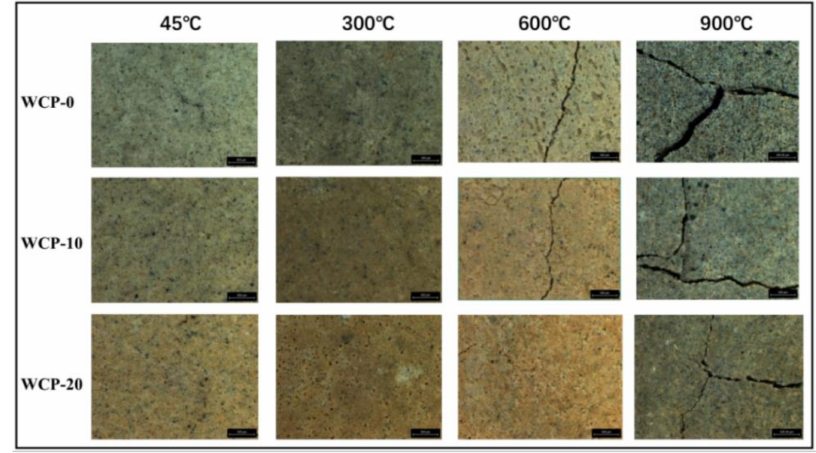
Figure 5. Mesoscopic images of all samples at different temperatures at 76